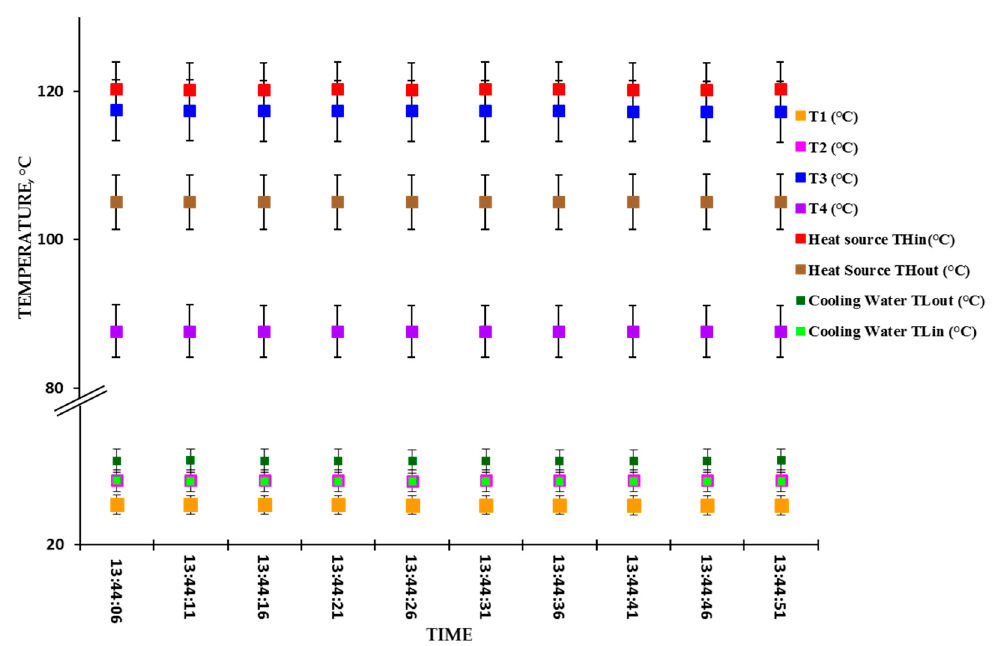
Figure 6. Temperature data in steady state condition for R245fa 1:1 R123 working fluid, mass flow rate of 0.125 kg/s and heat source 120 ° C with error bar 5%.